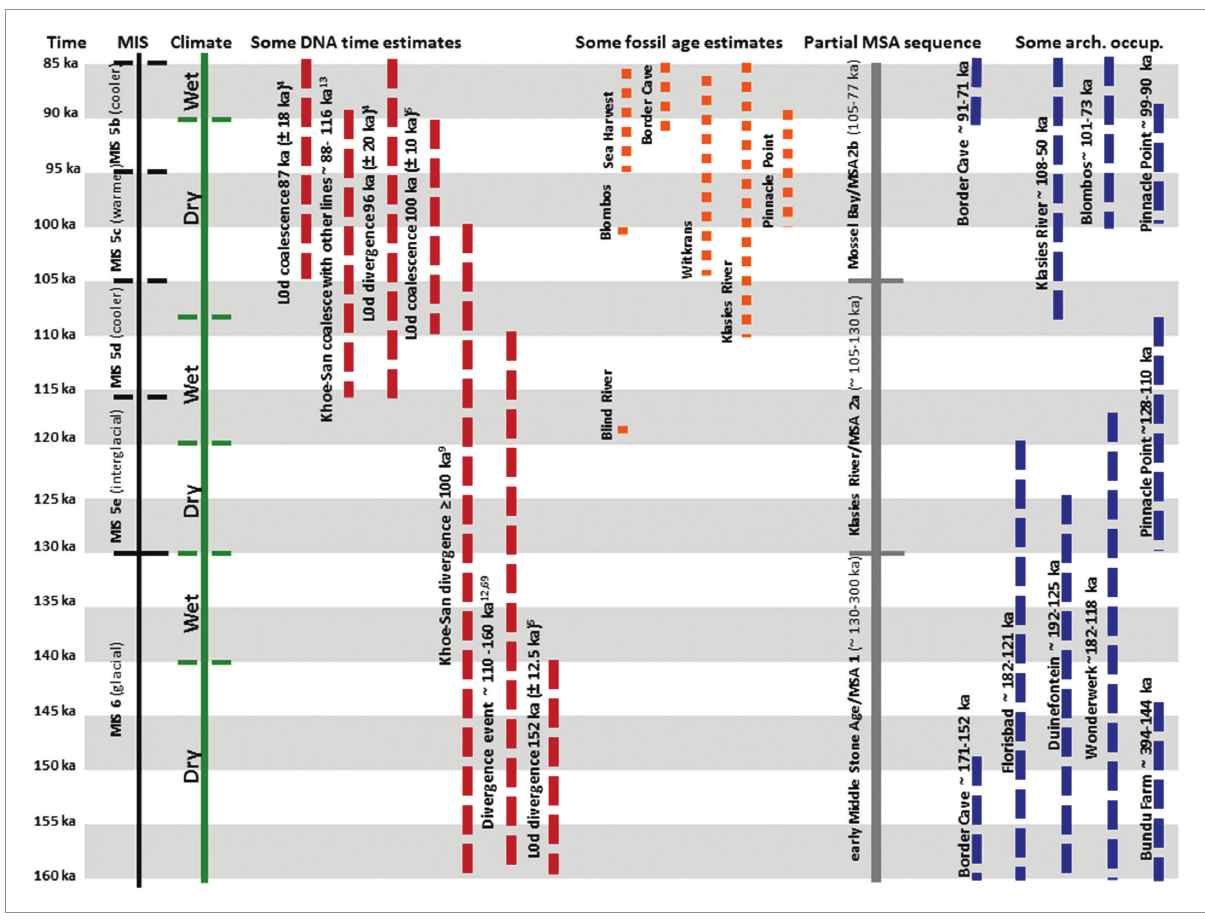
Figure 3: Timeline with relevant marine isotope stage (MIS) boundaries and generalised temperature interpretations, climatic inferences 14 , current interpretations of the DNA record based on different approaches 1,4,5,9,12,13 , age estimates for the relevant dated fossil record 22 , the revised archaeological sequence 33 and potential long-sequence sites where occupations might span gaps in the directly dated